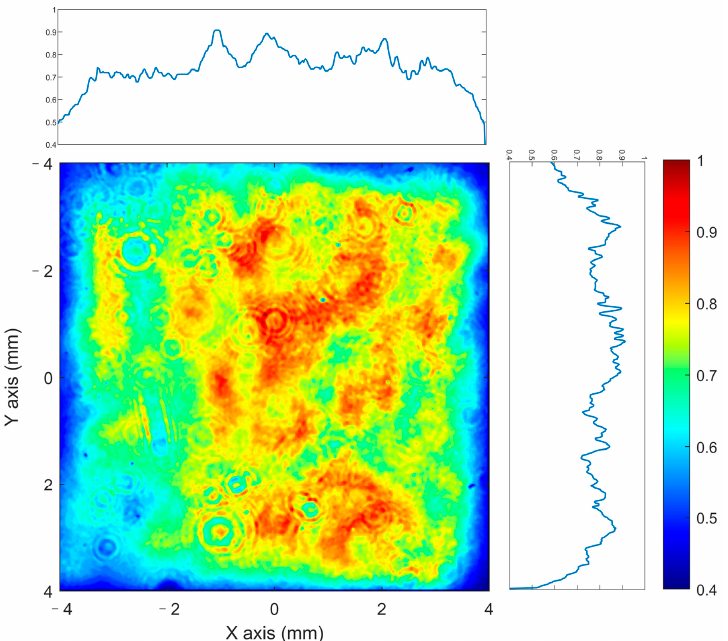
Figure 9. The near ‐ field profile with a twelve ‐ pass amplification output energy of 1.17 J.